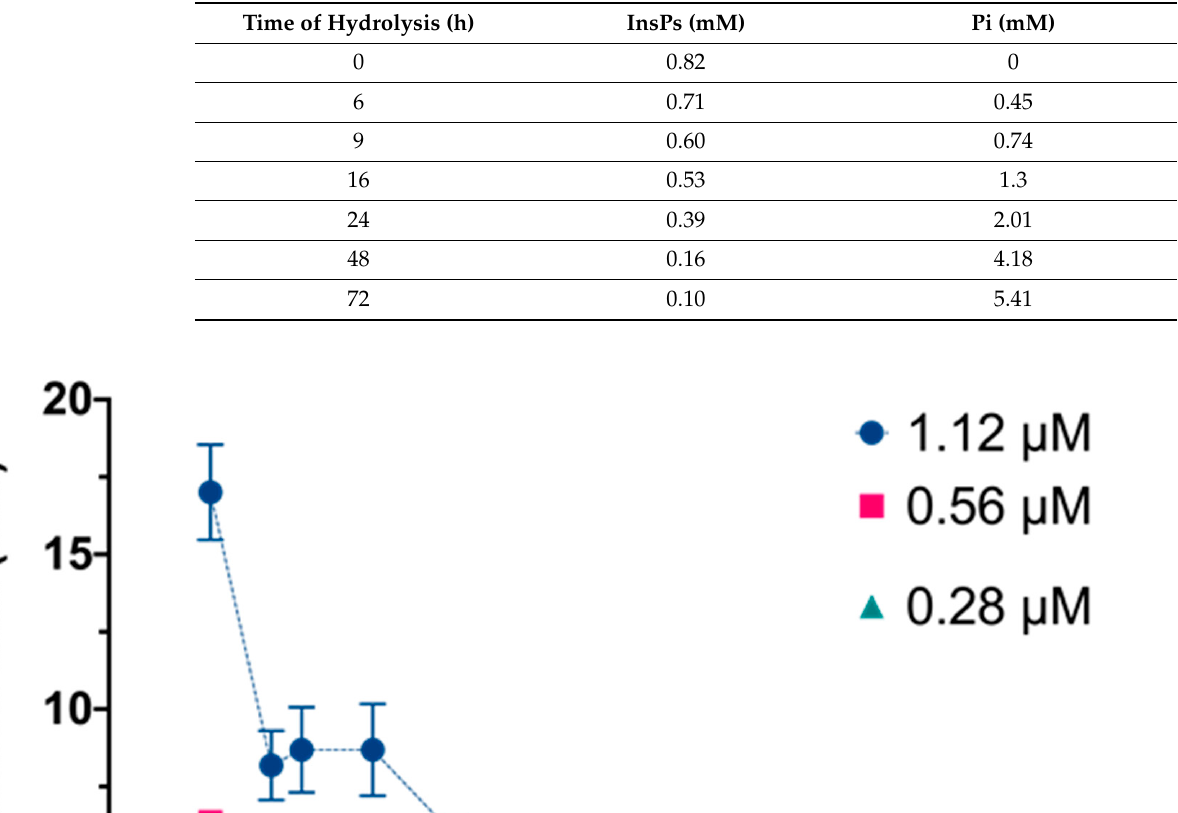
Table 2. Level of total InsPs and Pi after different times of hydrolysis. A non-specific method was used to determine InsPs (see Material and Methods).